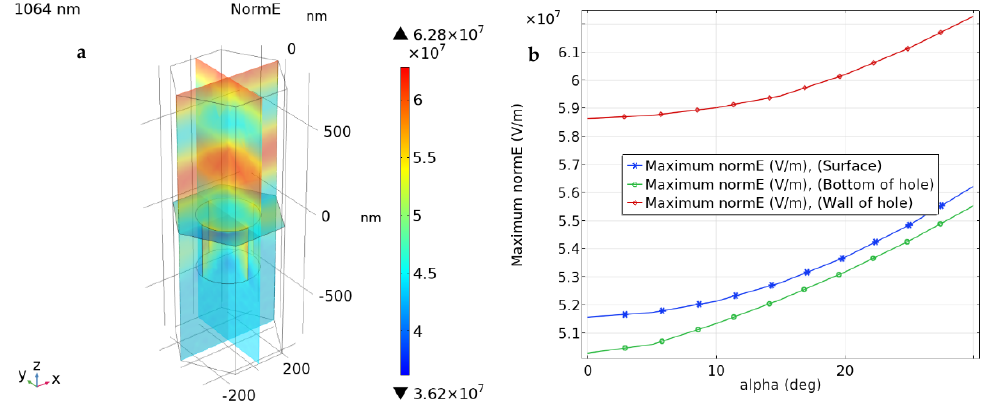
Figure 8. Electric field distribution of the 2D hexagonal array grating for 1064nm un-polarized waves. ( a ) The volume distribution of EFI at normal incidence. ( b ) EFI of the grating as a function of incident angle.